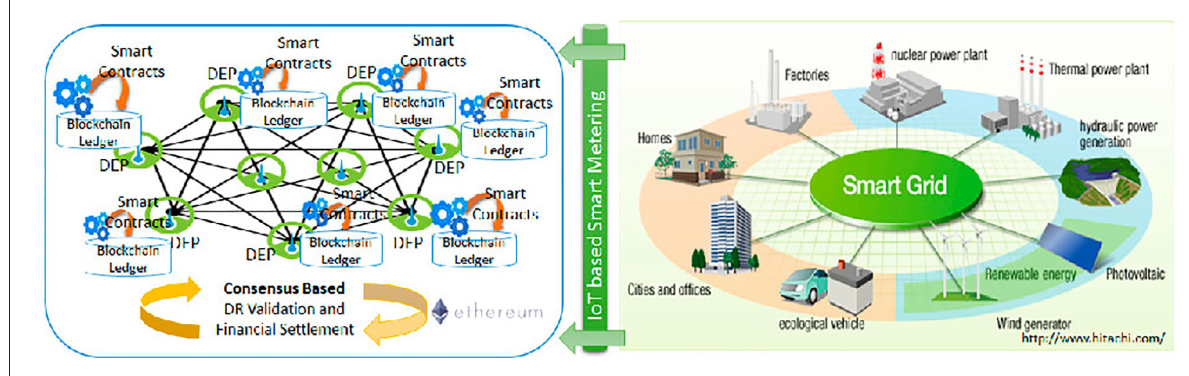
FIGURE8 Blockchian based decentralized management of energy grid (Pop et al., 2018).